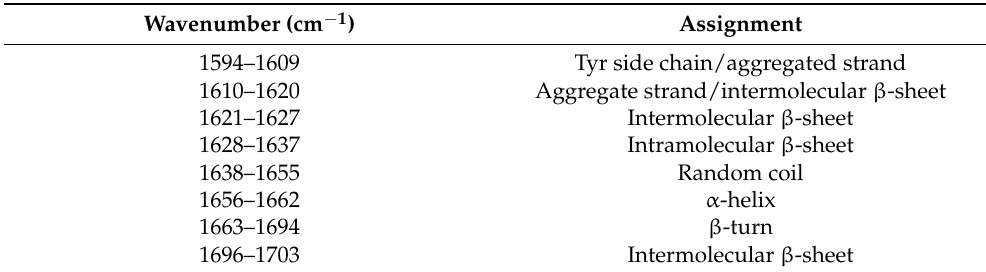
Table 2. Assignment of the elementary contributions in the amide I region